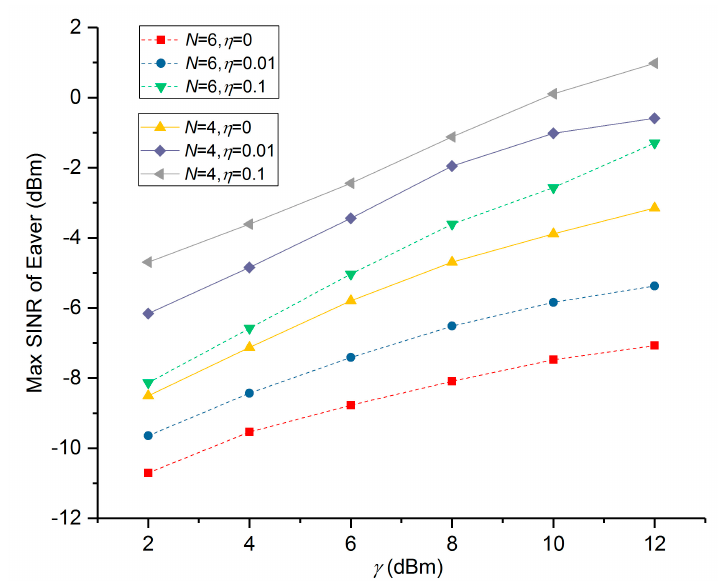
Figure 6. Maximum SINR of Eve versus SINR threshold of WMN nodes with different number of transmit antennas and channel estimation error thresholds.